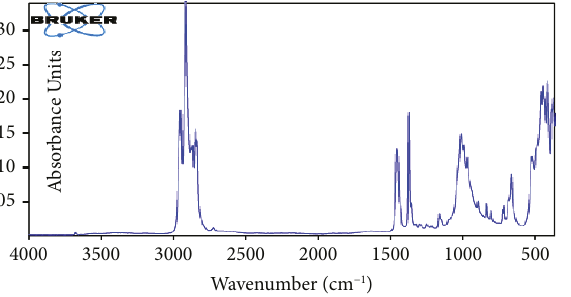
Figure 10: Nanocomposite after adsorbing dieldrin.